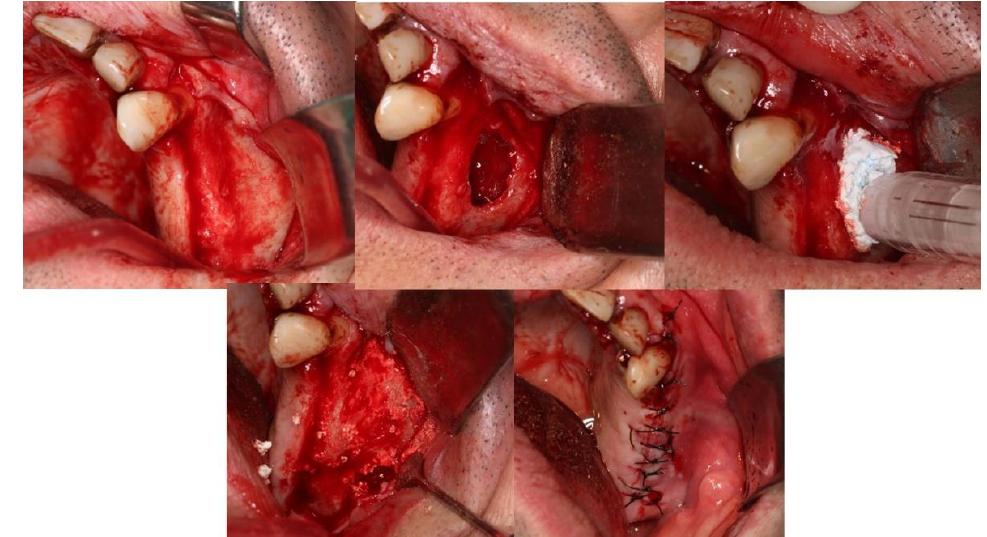
Figure 22. Intraoperative photographs.